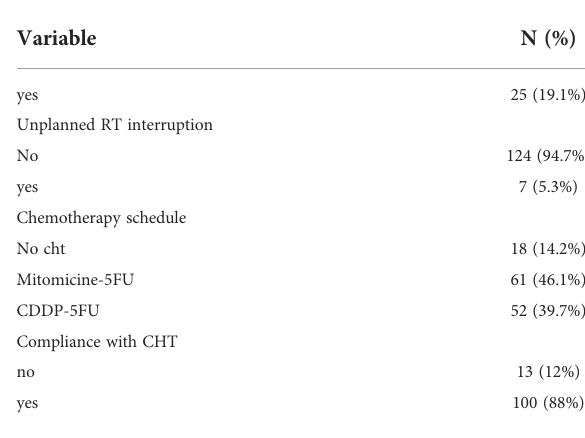
TABLE 1 Whole patient and treatment